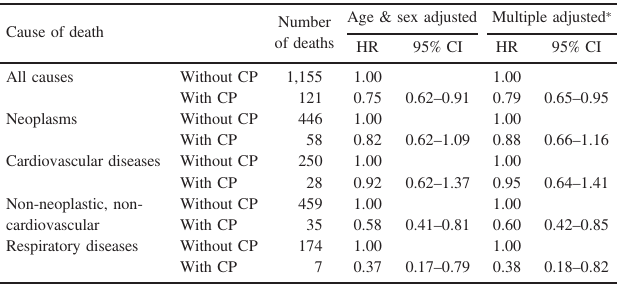
CI, con fi dence interval; CP, cedar pollinosis; HR, hazard ratio. + Adjusted for age, sex, BMI, physical activity, smoking status, alcohol consumption, education, marital status, and medical history of diabetes and hypertension. n = 25,549 person-years for participants with cedar pollinosis and n = 101,937 person-years for participants without cedar